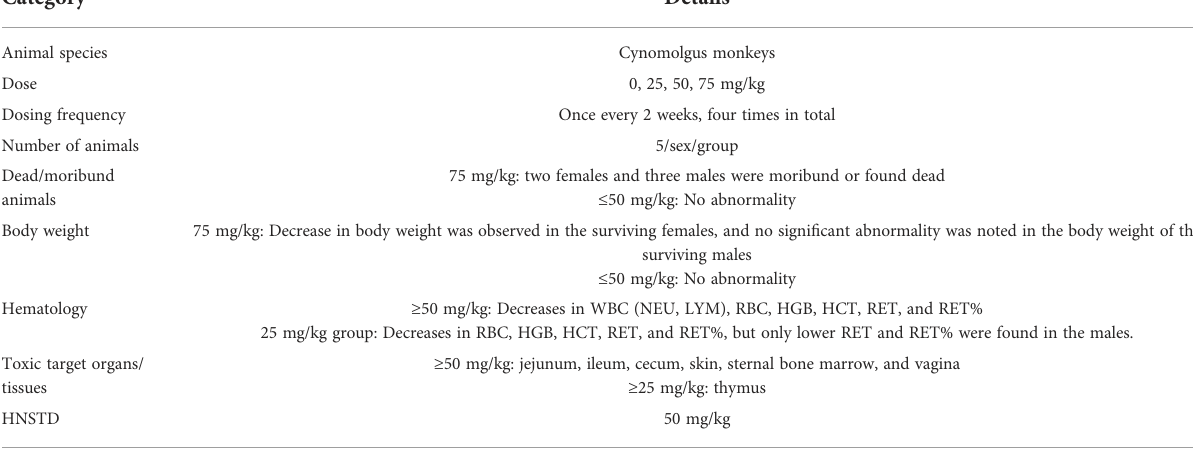
TABLE 1 Summary results of repeated SKB264 administration in cynomolgus monkeys.